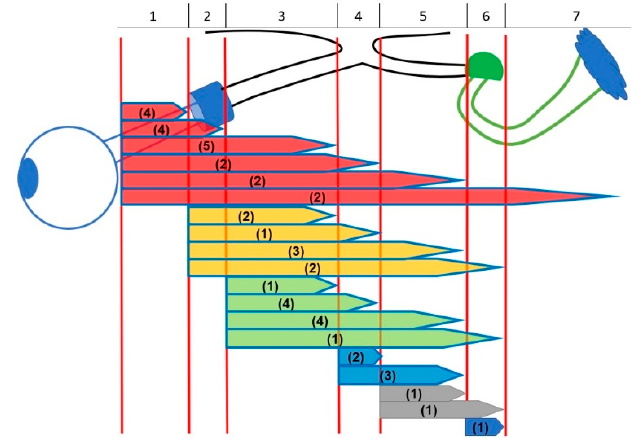
Figure 3. Different anatomic locations of optic pathway gliomas. Extension of tumors: (1) intraconal (posterior boundary orbital apex); (2) intracanalicular (posterior boundary optic foramen); (3) intracranial ‐ prechiasmatic; (4) chiasmatic; (5) optic tract; (6) lateral geniculate nucleus; (7) optic radiation. Number of patients in brackets ( n = 45).